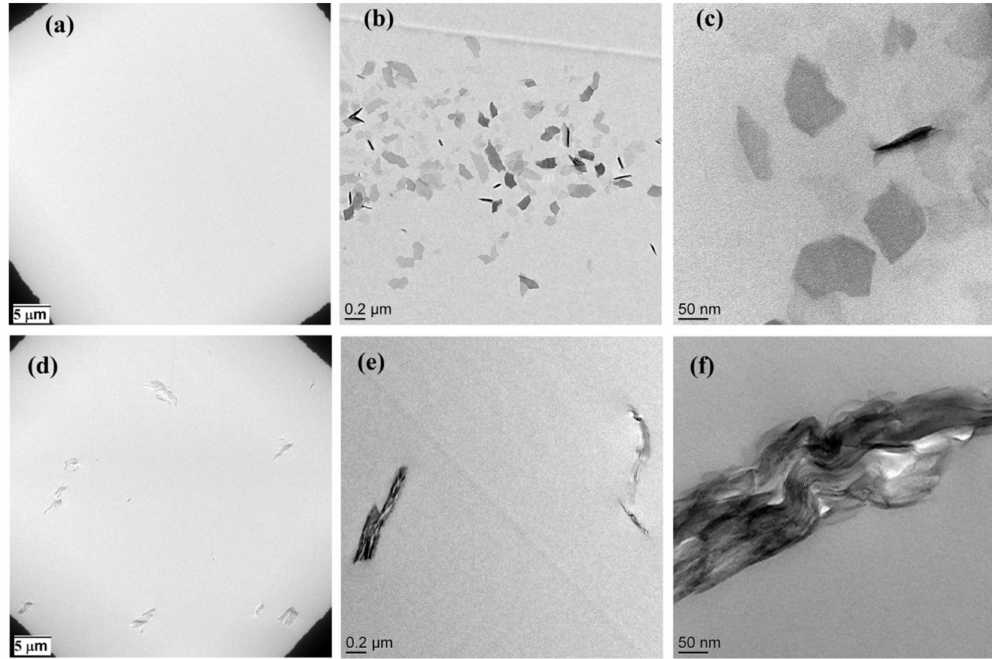
Figure 4. TEM images of the Mica-IM ( a – c ) and Mica ( d – f ) dispersed into epoxy matrix at 0.1 wt %.